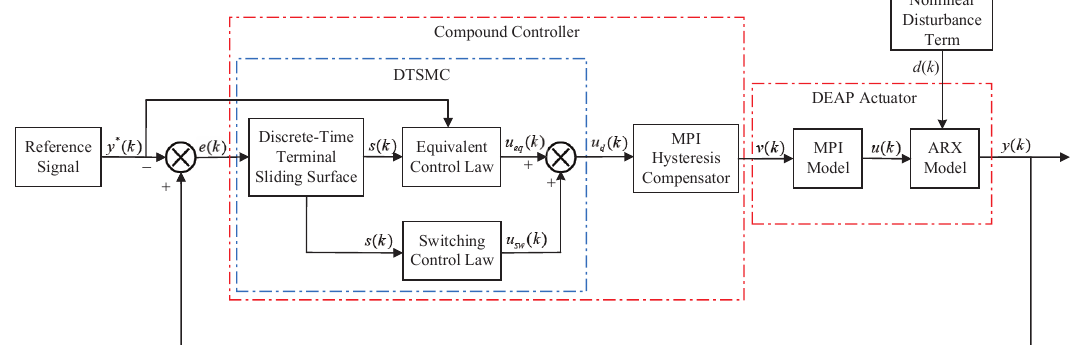
Figure 7. The structure of the compound